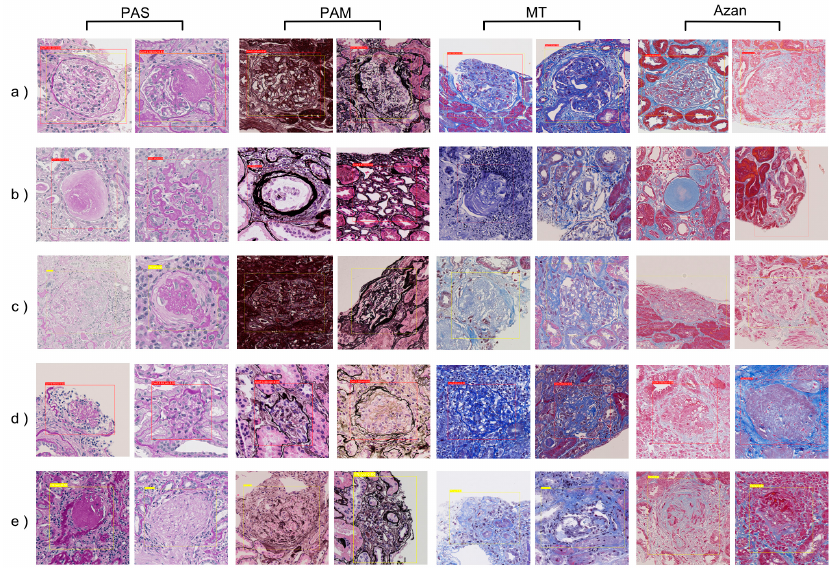
Figure 4. Typical examples of TP, FP, FN, and incorrectly annotated glomeruli in each stain. ( a ) TP cases. Both normal (left) and abnormal (right) cases were detected as glomeruli; ( b ) FP cases. There was a tendency to incorrectly detect single (left) or multiple (right) tubules as glomeruli; ( c ) FN cases. The tendency of FN is unclear; ( d ) FP cases found to be glomeruli after review; ( e ) FN cases found not to be glomeruli after review. TP, true positive; FP, false positive; FN, false negative; PAS, periodic acid ‐ Schiff; PAM, periodic acid ‐ methenamine silver; MT, Masson trichrome.